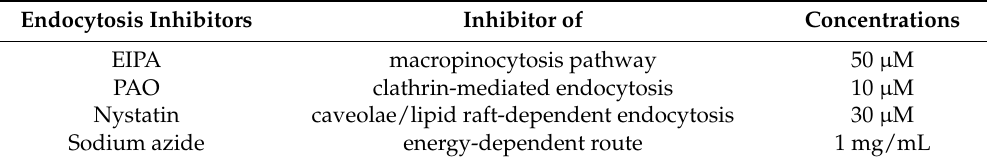
Table 1. Inhibitors with different endocytosis functions and the concentrations [17]. Endocytosis Inhibitors Inhibitor